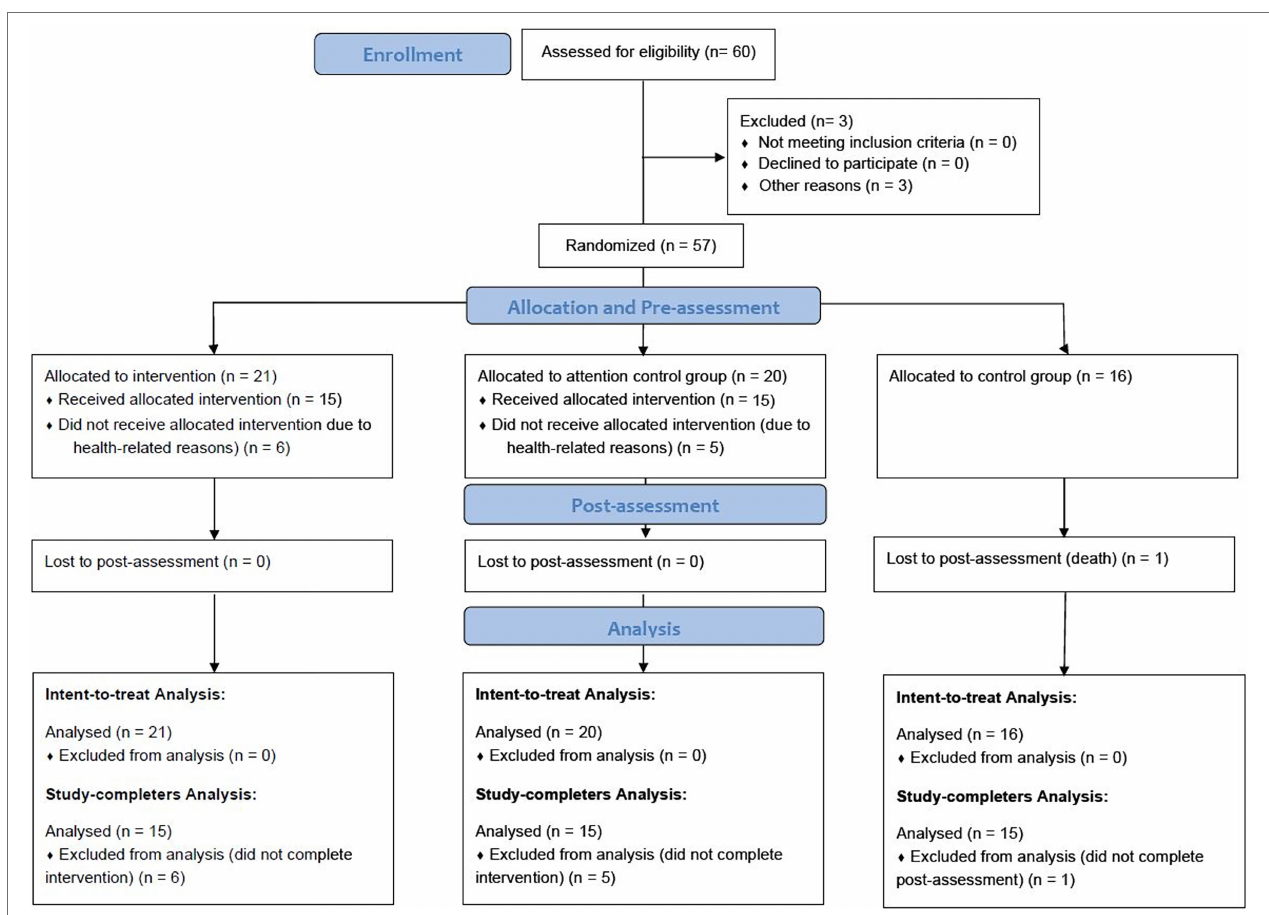
FIGURE 1 | Participant